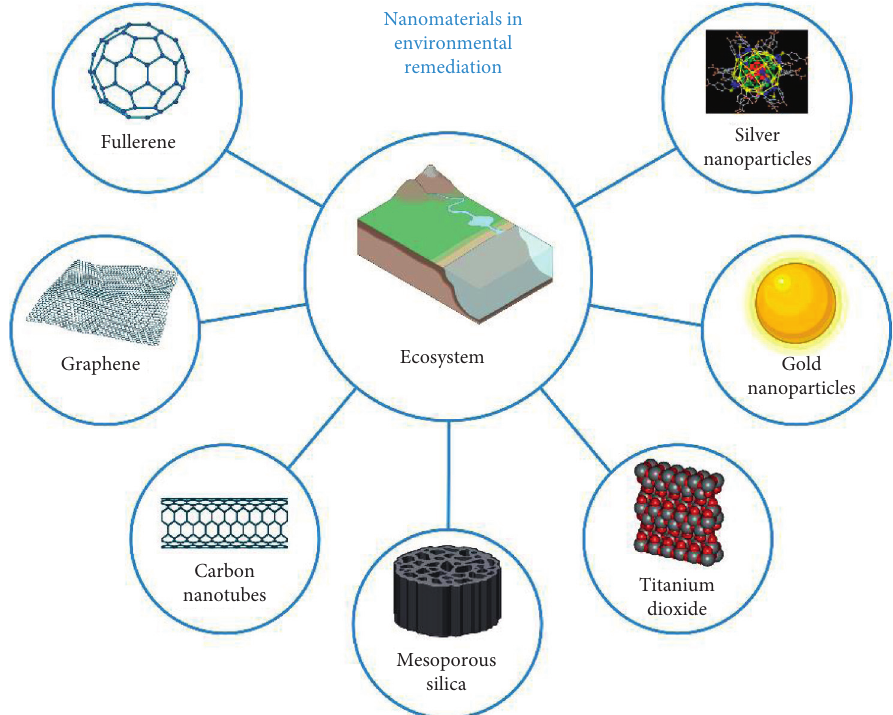
Figure 4: Different types of nanomaterials involved in environmental remediation. Created using